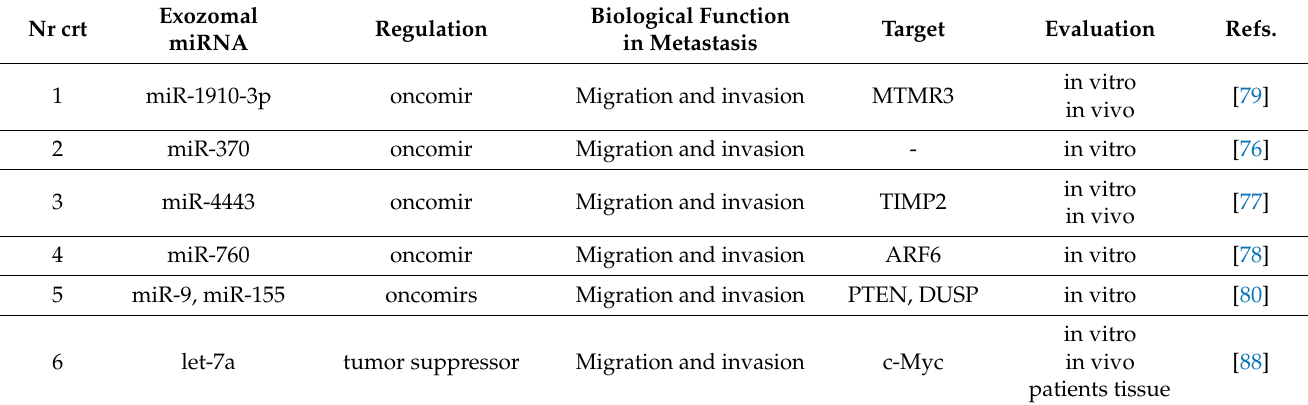
Table 3. Exosomal miRNAs from preclinical models.